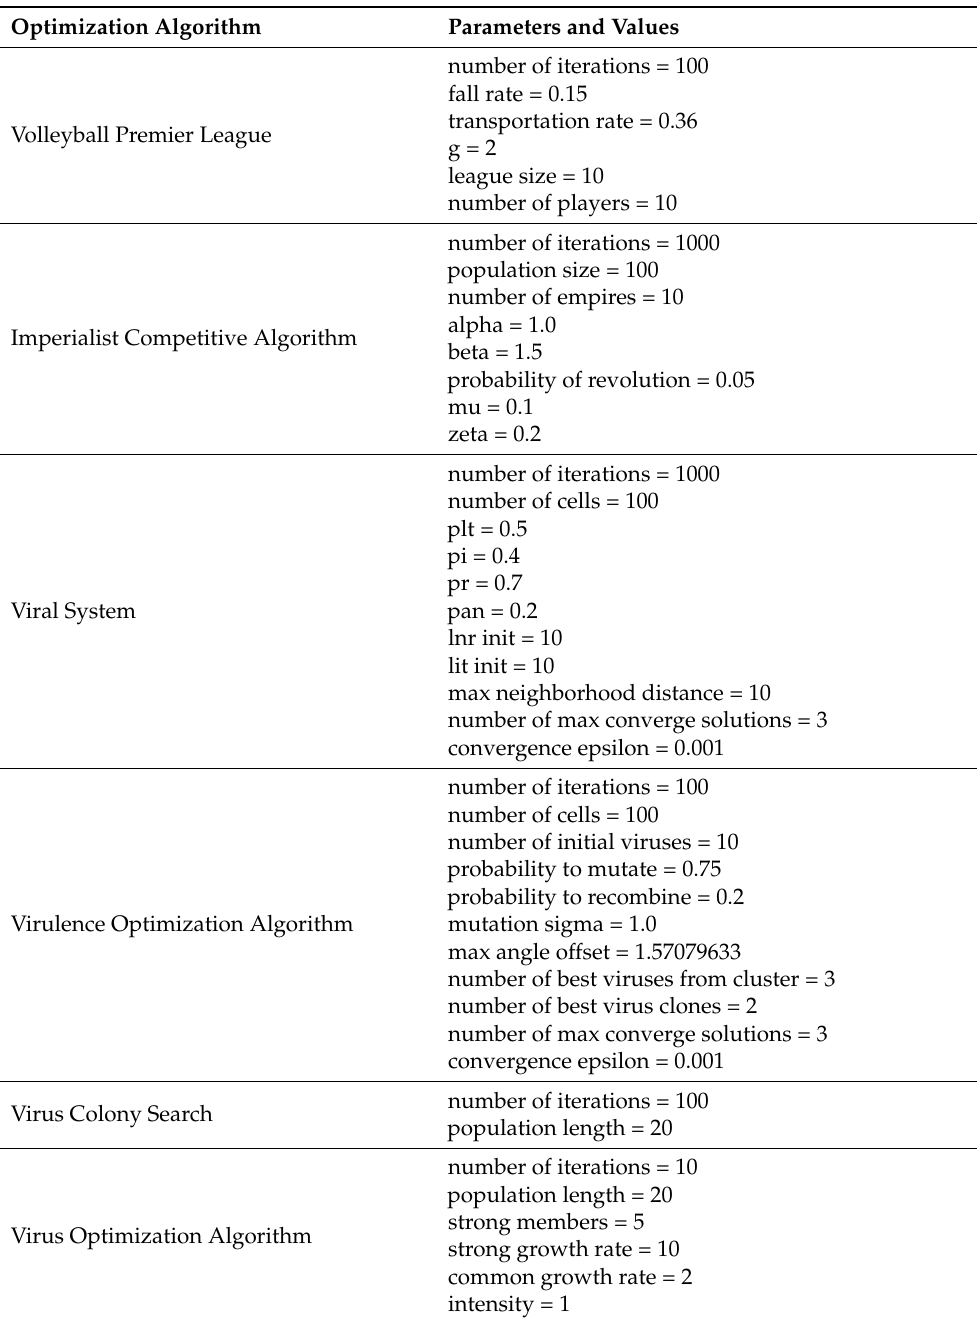
Table A1. Cont. Optimization